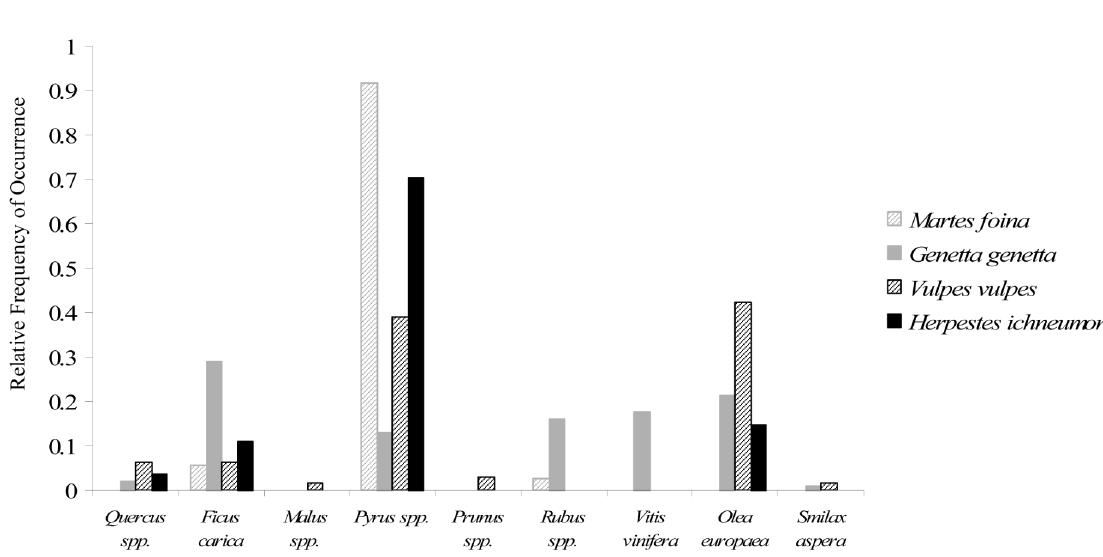
Fig. 3. Relative frequency of occurrence of fruits consumed by four carnivores in SW Portugal (family Fagaceae: Quercus spp.; family Moraceae: Ficus carica ; family Rosaceae: Malus spp., Pyrus spp., Prunus spp., Rubus ulmifolius , family Vitaceae: Vitis vinifera ; family Oleaceae: Olea europaea ; family Smilacaceae: Smilax aspera